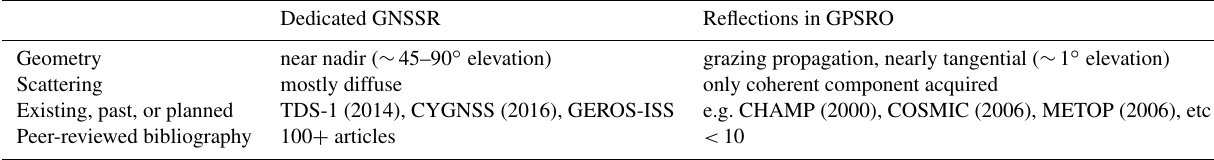
Table 1. Comparison between dedicated GNSS reflectometry missions, and reflected signals during GPSRO radio occultation events. Exam- ple past or planned missions are shown, with one or the other technology. Launch years are included. This paper solely addresses reflections during